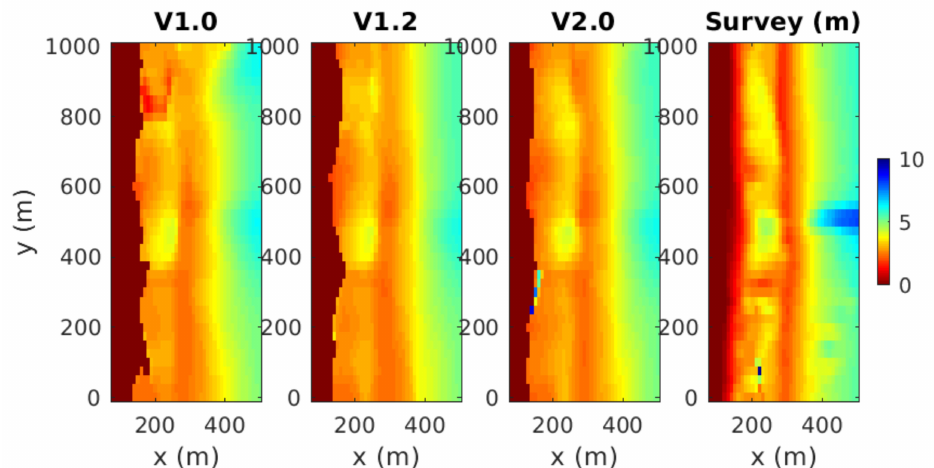
Figure 20. Comparison of Kalman-filtered bathymetry from the three version of cBathy, V1.0, V1.2, and V2.0 ( left three panels) for 21 November 2017, with the ground-truth survey from that day ( right panel). This is the same survey used in Figure 8. All cBathy results have been filtered to remove any values with an estimated error greater than 0.5